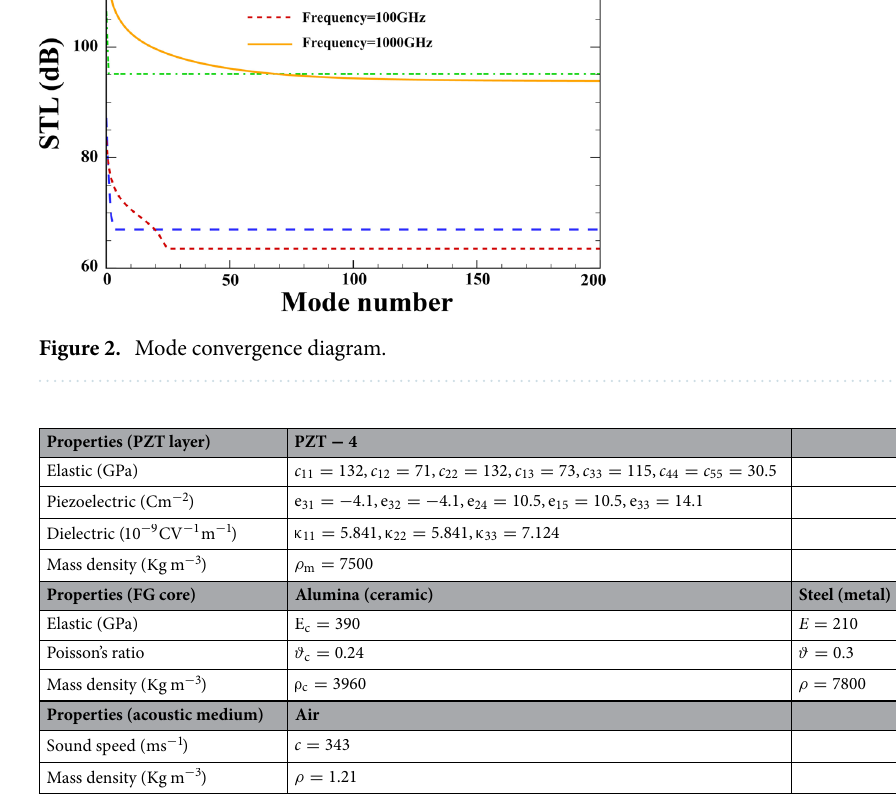
Table 1. Material properties of the sandwich FG-PZ cylindrical nanoshell.